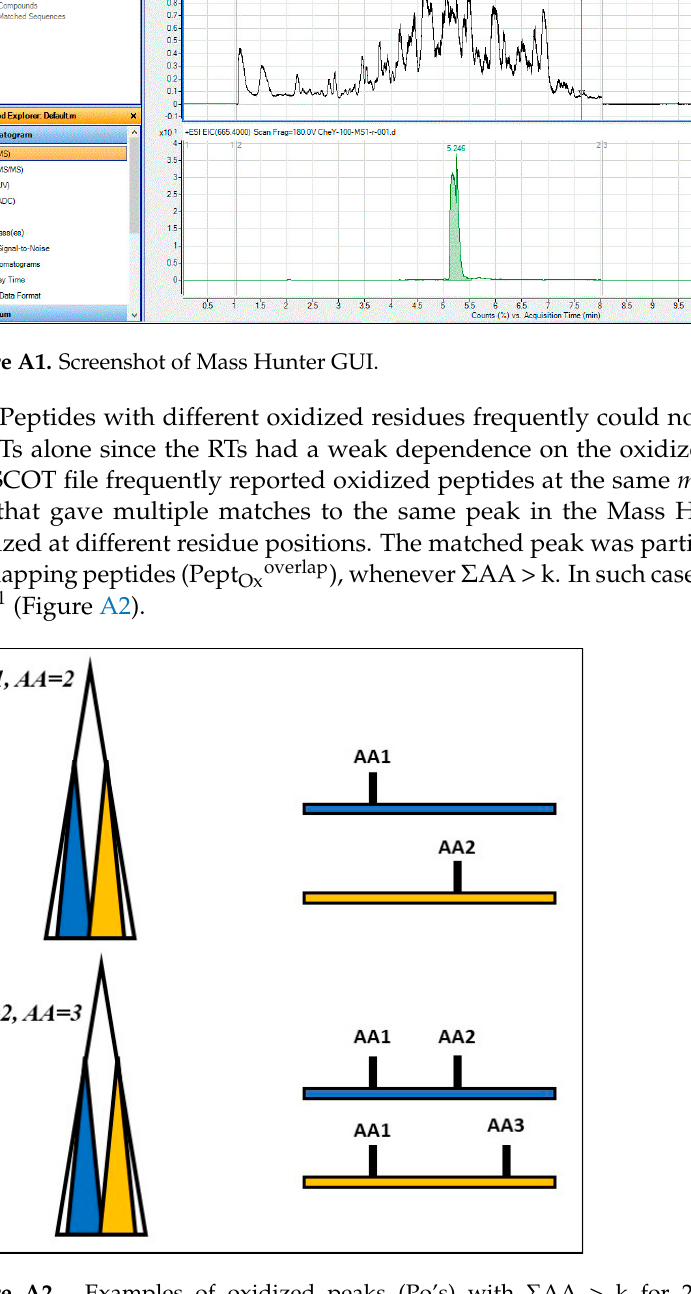
Figure A2. Examples of oxidized peaks (Po’s) with Σ AA > k for 2 overlapping peptides ( Σ Pept Oxoverlap = 2). (a) k = 1, Σ AA = 2. (b) k = 2, Σ AA = 3. For Σ Pept Oxoverlap = 3 or >, the equations have extra terms, but the logic is the same. Overlapping peptides do not occur for unoxidized peaks (Pu’s).